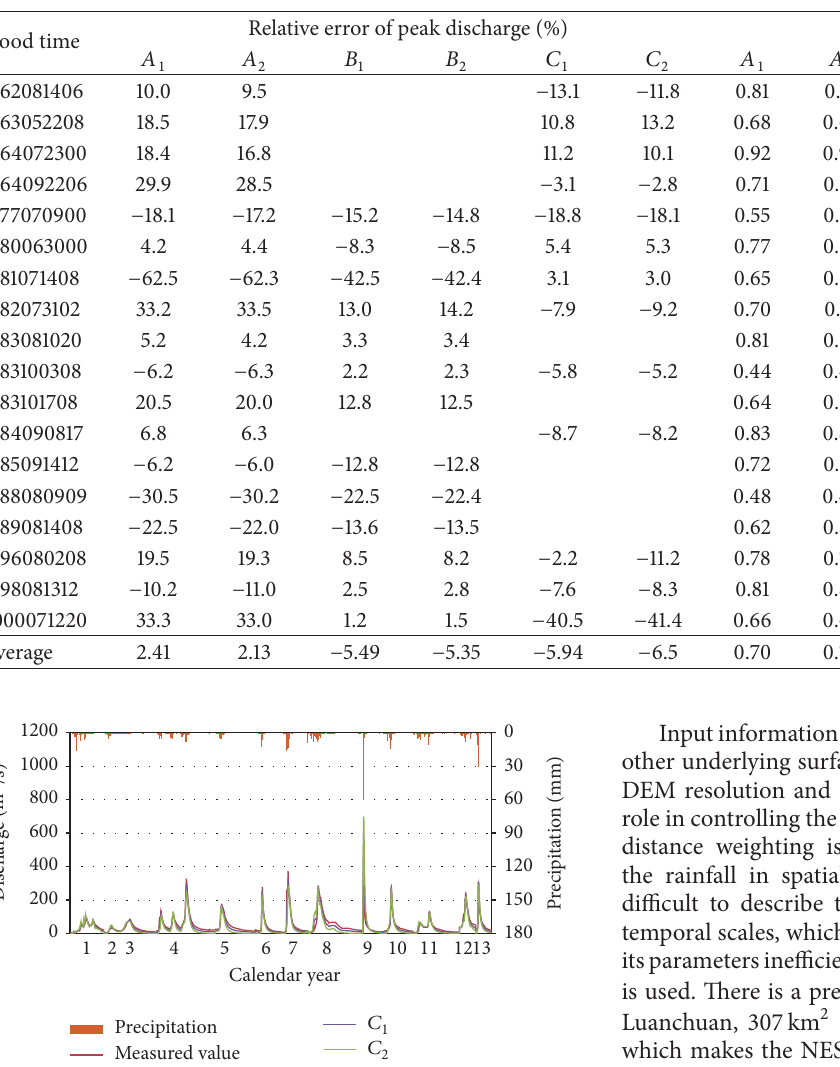
of relative error of peak discharge in 𝐵 1 (from − 42.5% to 13.0%) and 𝐶 1 (from − 40.5% to 11.2%) is smaller than 𝐵 2 (from − 42.4% to 14.2%) and 𝐶 2 (from − 41.4% to